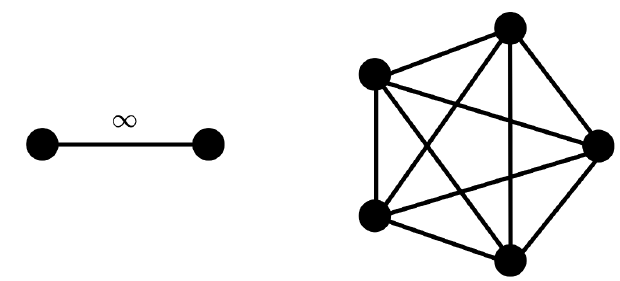
Figure 3 . Coxeter graphs of the groups G for the examples discussed in this paper. Left: Coxeter diagram of CICY 7863 from the example in section 3.4 and CICY 7880 from the example in section 4.3.1. Right: Coxeter diagram of CICY 7447, the mirror of the Hulek-Verrill manifold, from the example in section